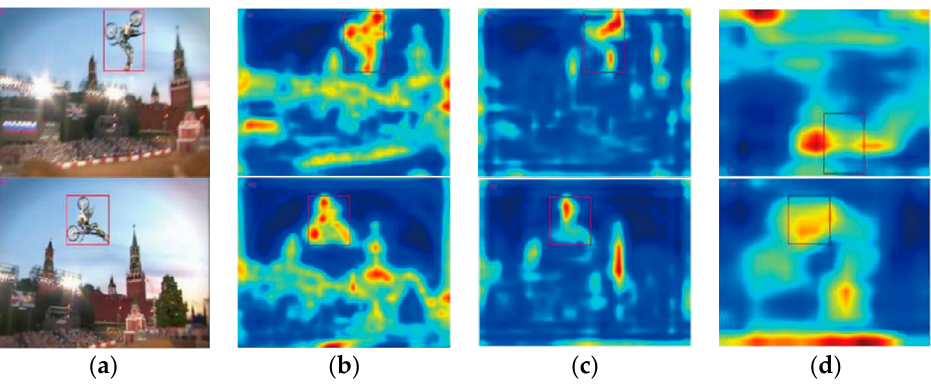
Figure 2. Convolutional features response: ( a ) original images, ( b ) Conv3-4, ( c) Conv4-4, and ( d ) Conv5-4.